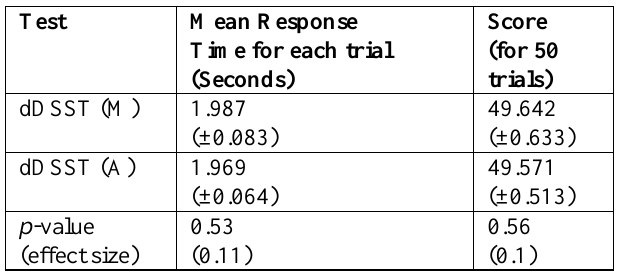
Table 6 dDSST test performance metrics (Average ±SD) on 50 trials for the morning (M) and afternoon (A)